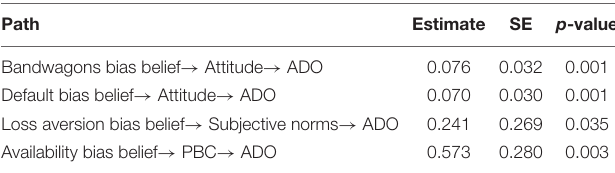
TABLE 6 | Standardized indirect effects of biased beliefs on behavioral